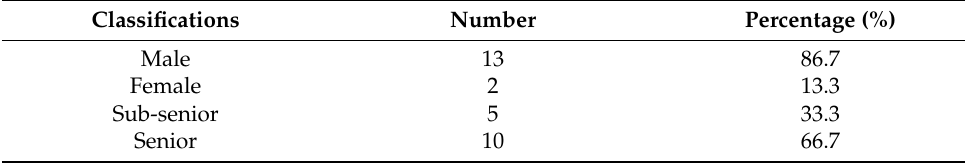
Table A1. Composition of experts.